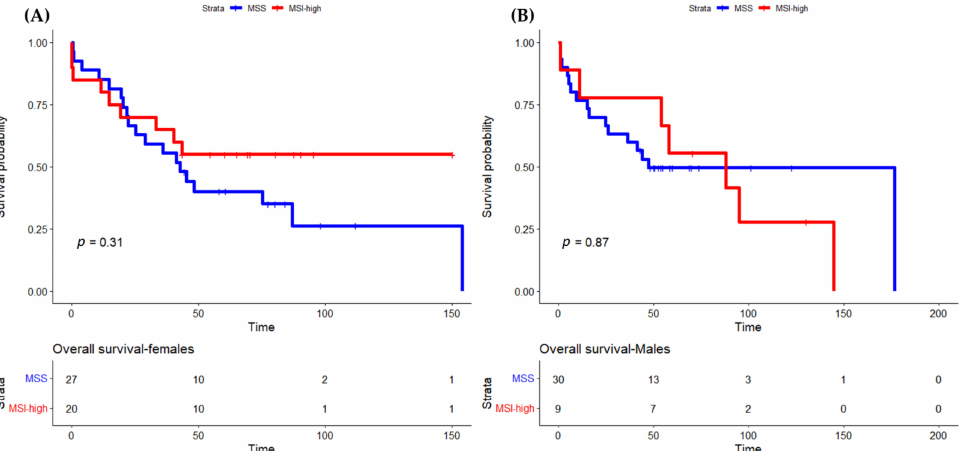
Figure 2. Overall survival by MSI status in females ( A ) and males ( B ). MSI, microsatellite instability; MSS, microsatellite stable.